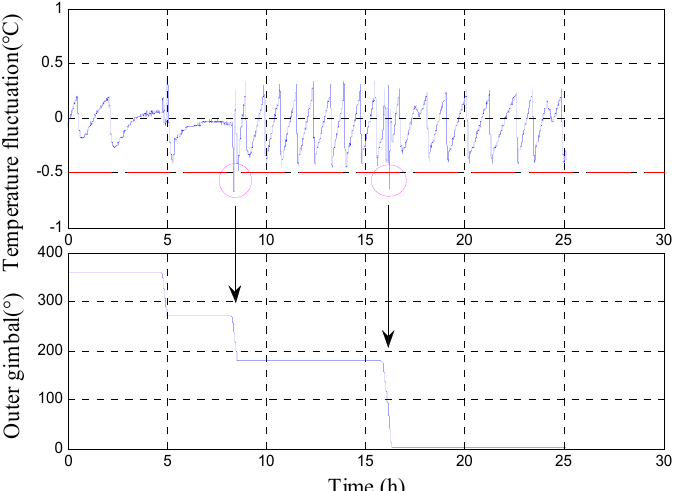
Figure 8. Temperature fluctuation of the temperature control system.